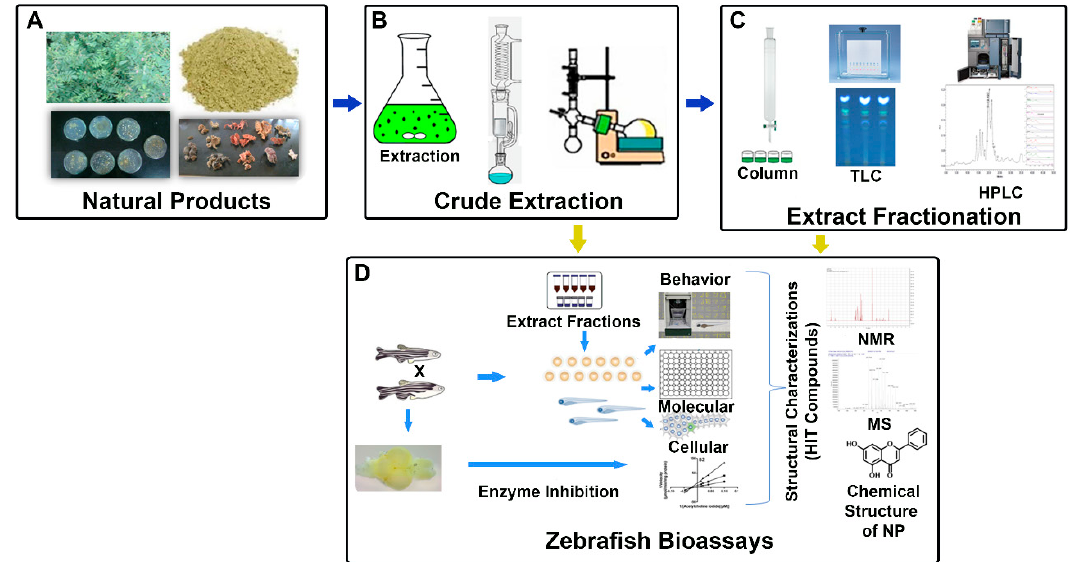
Figure 1. Schematic representation of zebrafish bioassay-guided isolation of natural products. ( A ) Different sources of natural products. ( B ) Crude extraction of natural products. ( C ) Purification of biologically active compounds from various chromatographic methods. ( D ) Various zebrafish biological assays and structural characterization of HIT compounds using different spectroscopic techniques. (HPLC: high performance liquid chromatography; MS: mass spectrometry; NMR: nuclear magnetic resonance spectrometry; NPs: natural products; and TLC: thin-layer chromatography).